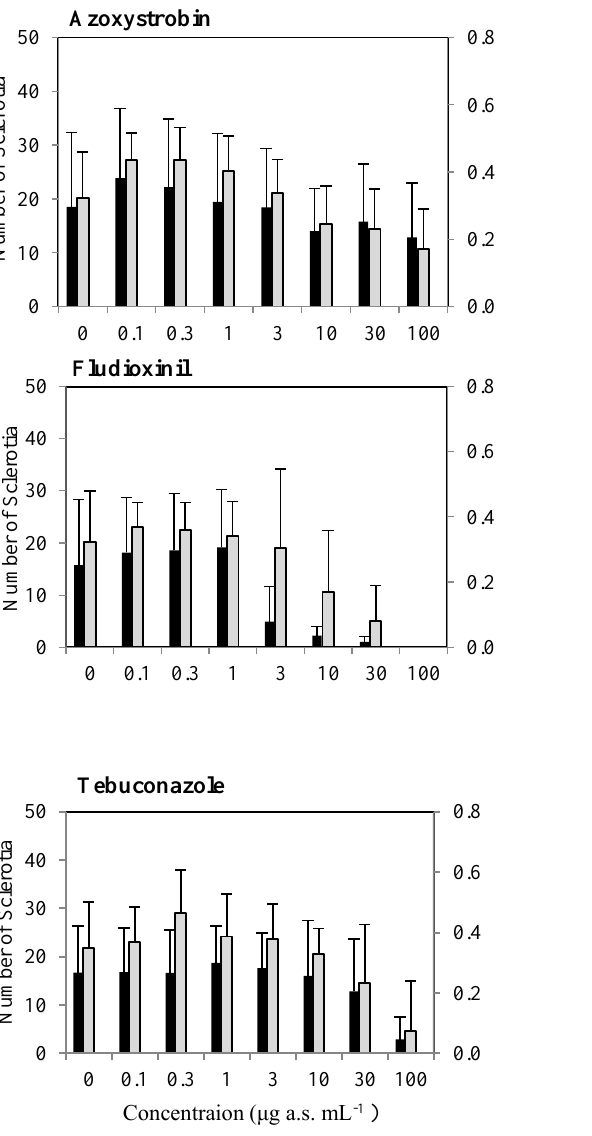
Figure 2. Effect of different fungicides on sclerotia formation (black bars) and the weight of them (grey bars). To evaluate the inhibitory effect of five fungicides as well as a biopesticide on production of sclerotia of S. sclerotiorum ( n = 68) in-vitro, potato dextrose agar (PDA) was amended with the fungicides at seven concentrations. Plates incubated in 25 °C in darkness for 21 days for sclerotia formation. Each column indicate mean value ± standard deviations (error bars).